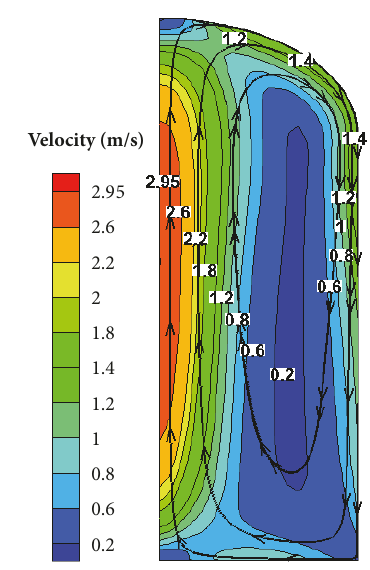
Figure 10: The distribution of condensation mass flux along the vertical condensation wall.